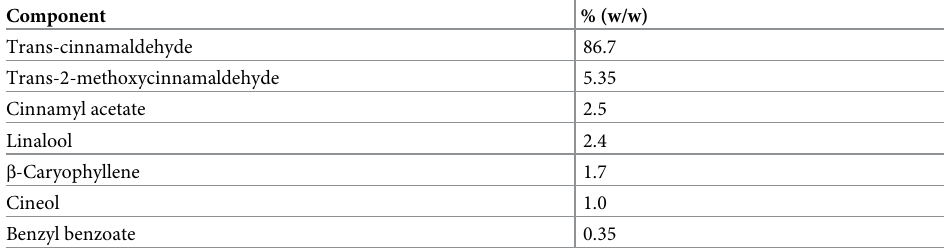
Table 1. Chemical composition of CIN-102. A well-defined synergistic blend with antibacterial and antifungal